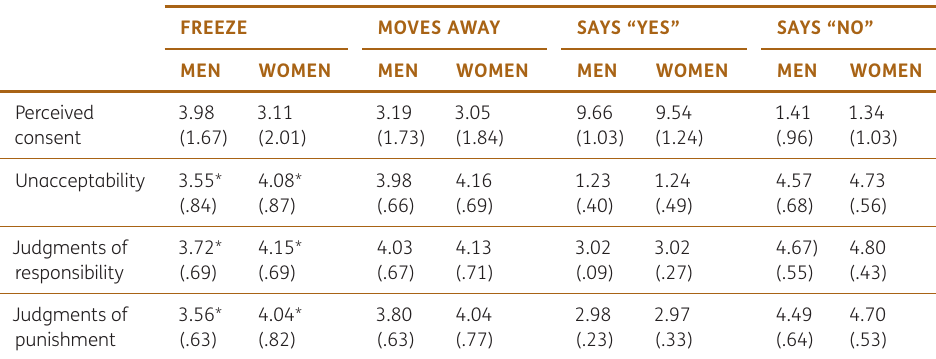
Table 4 Means (and SDs) for judgments by response and sex. Note : Perceived consent was coded as 1 = definitely not consent to 10 definitely consent. Unacceptability was coded from 1 = definitely OK to 5 definitely not OK; Judgments of responsibility and who should be punished were coded 1 = definitely the victim 3 neither or both and 5 definitely the perpetrator.